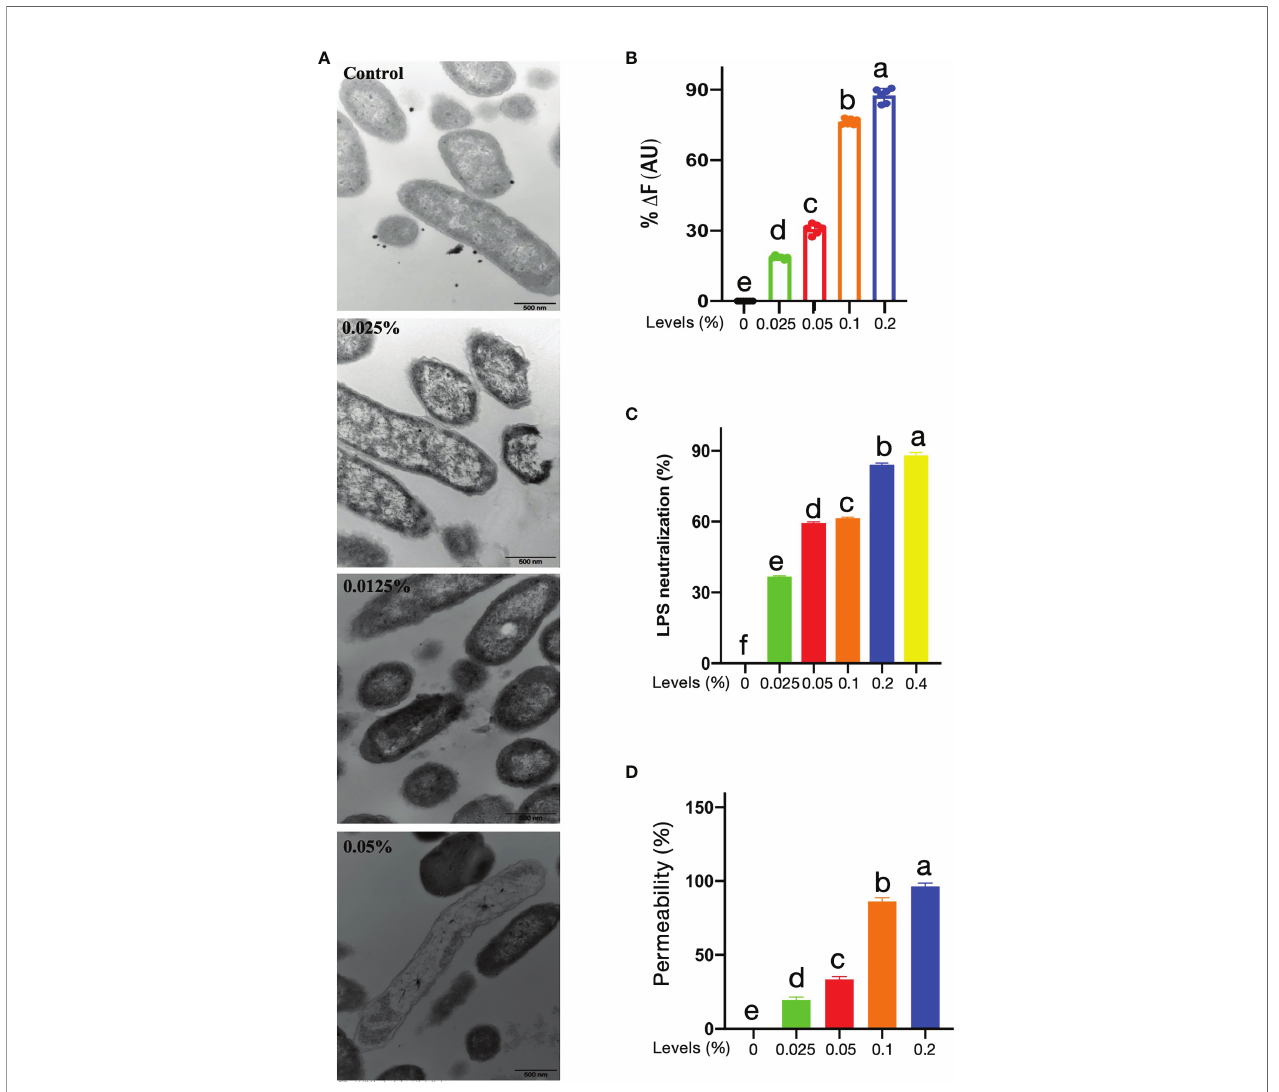
FIGURE 2 | Potential of mechanism of CNMs. (A) Transmission electron microscopy micrographs of Tet-resistant ETEC treated with CNMs. Stationary-phase bacteria cells at around 10 6 cfu/ml were treated with different concentrations of CNMs for 1 h. The change of cytoplasmic membrane was determined. Control, untreated; 0.025% of CNMs, 1 × MIC; 0.05% of CNMs, 2 × MIC; 0.1% of CNMs, 4 × MIC. Images are presented in three independent experiments. (B) LPS-binding af fi nity and (C) endotoxin neutralization of the CNMs at variant levels were tested by the BODIPY-TR cadaverine fl uorescent dye displacement assay and chromogenic limulus lysate, respectively. Data are presented as the means ± standard error of three independents trials. (D) Outer membrane permeabilization of Tet-resistant ETEC treated with different levels of CNMs was determined using N-phenyl-1-naphthylamine (NPN) dye. The fl uorescence was measured to indicate the permeability. Data are presented as the means ± standard error of three independents trials. (B – D) values that different lowercase are signi fi cantly different (P < 0.05) in each bar